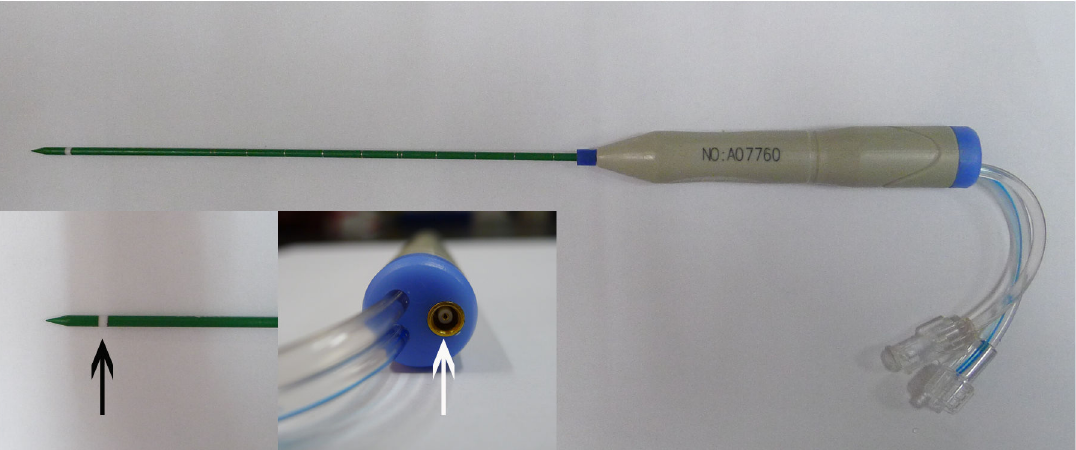
Figure 1. Cooled-shaft microwave antenna used in this study. The radiating segment (black arrow) embedded in the front, and the end socket (white arrow) was used to connect the plug of cable coming from the microwave generator. doi: